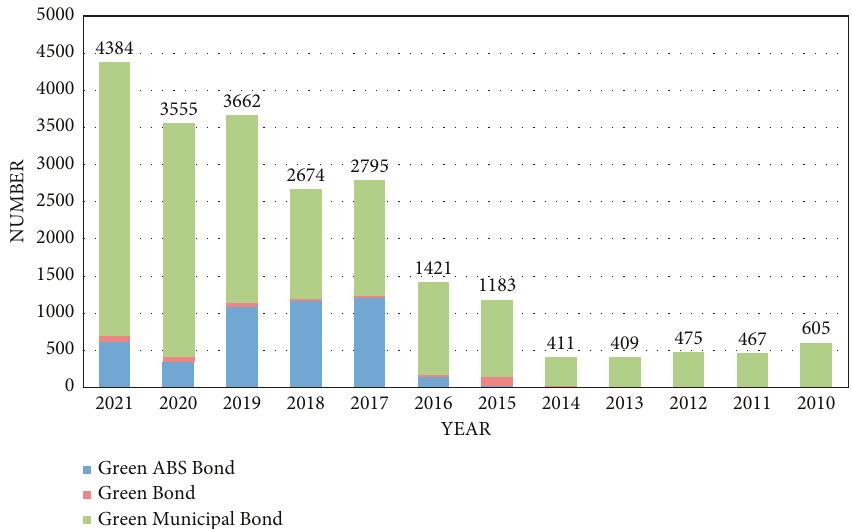
Figure 5: Annual Green Bond Issuance Number in the US (Data source: Bloomberg, compiled by the author).